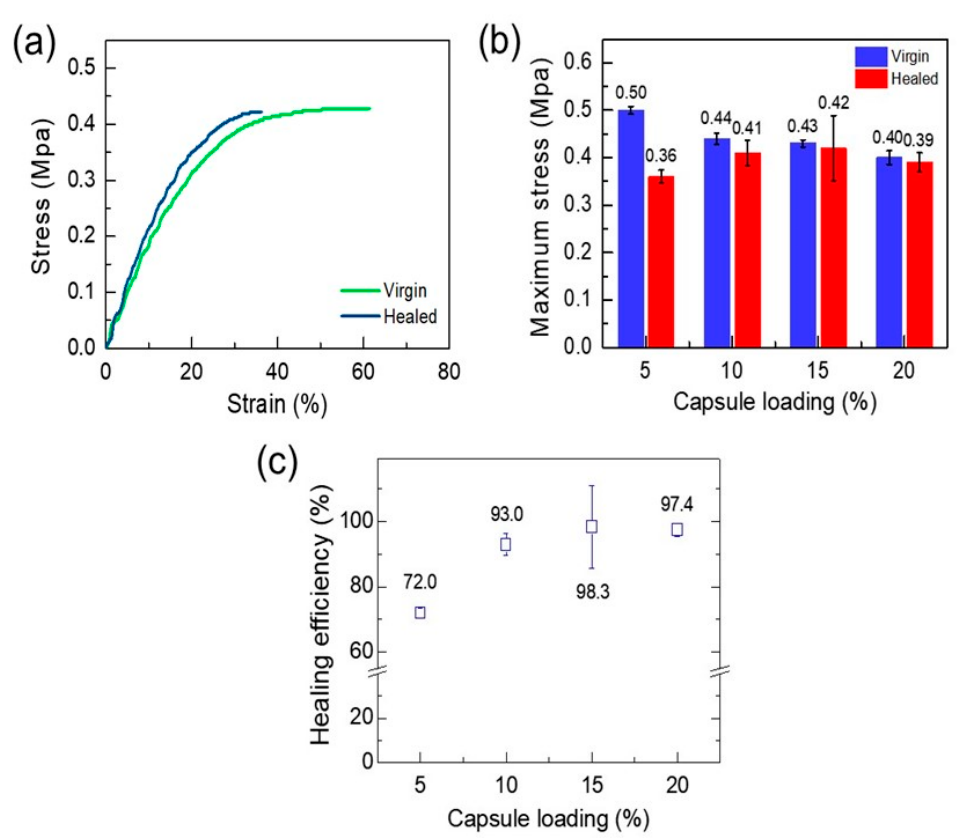
Figure 7. ( a ) Stress–strain curves of the virgin and the healed EPDM/microcapsule rubber composites with 15 wt% of the mechanically-enhanced UF microcapsules. ( b ) The maximum stress values of the virgin and the healed EPDM/microcapsule rubber composites. ( c ) The self-healing efficiencies of the EPDM/microcapsule rubber composites with different amounts of the mechanically-enhanced UF microcapsules.